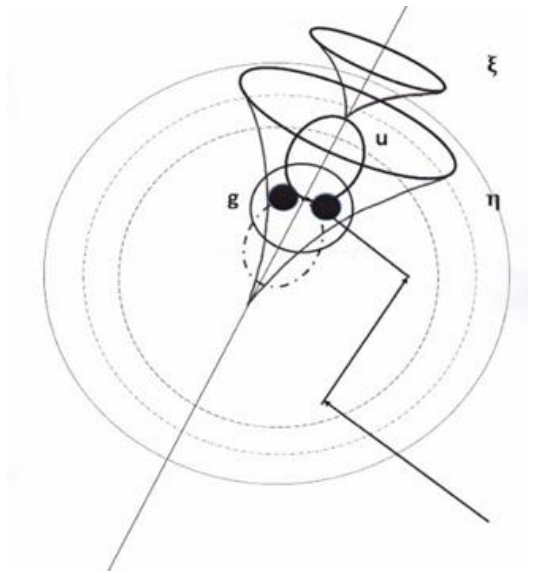
Figure 6 : The Scattering. One hydrogen molecule whose center m follows a fast and erratic random walk inside a solid potential well is represented at a moment when the molecule scatters the solid. The molecule is represented by the two protons and its internuclear axis. The 2 molecular electrons are distributed in the bonding and almost spherical g (1s) state. Dotted circles figure the solid well equipotential. The empty molecular antibonding u (1s) state, figured by an ellipse, approaches higher potentials (repulsive hard wall). A pair of conduction and valence state exponential tails of axial symmetry are directed towards the molecule. The 𝛈𝛈 𝛏𝛏 excited state has a much larger extension and overlaps appreciably with the molecular antibonding state. 𝛈𝛈